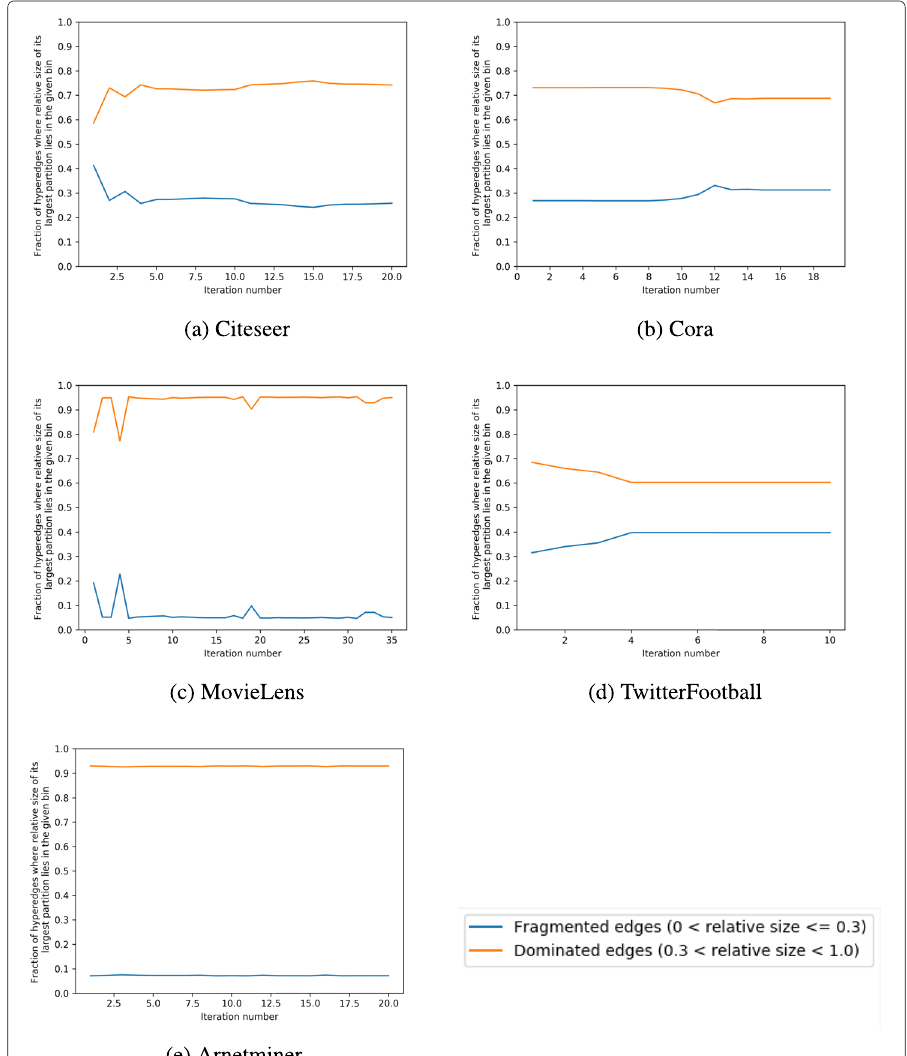
Fig. 4 Effect of iterative hyperedge reweighting: % of hyperedges where the relative size of its largest partition falls in a given bin vs. no. of iterations